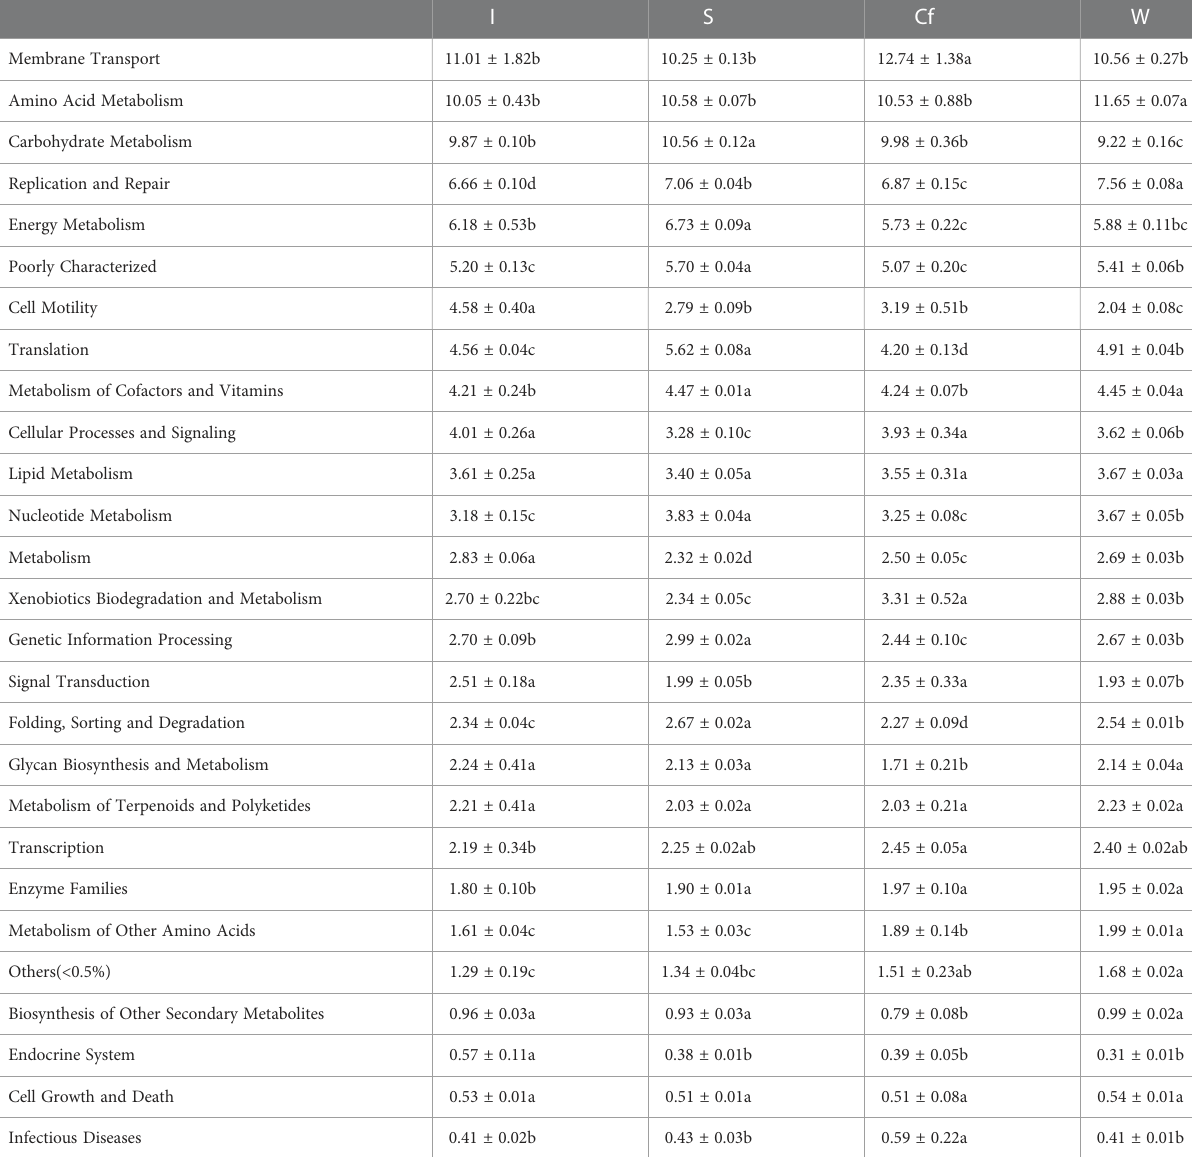
TABLE 3 The functional composition of bacteria community of different